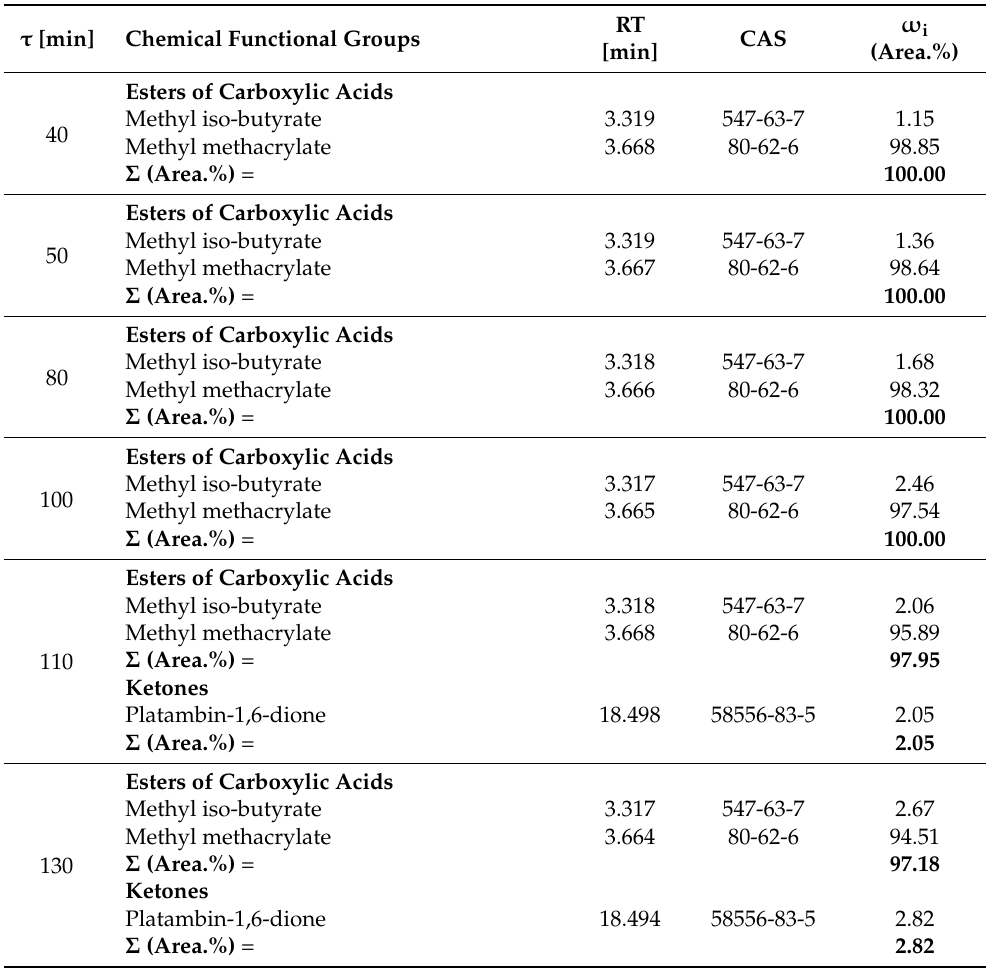
Table 8. Functional groups, sum of peak areas, chemistry registry numbers (CAS), and retention times of molecules identified by gas chromatography-mass spectrometry (GC-MS) in the liquid phase by depolymerization of PMMA based dental resins fragments/residues at 420 ◦ C, atmospheric pressure, and time interval of 40 to 130